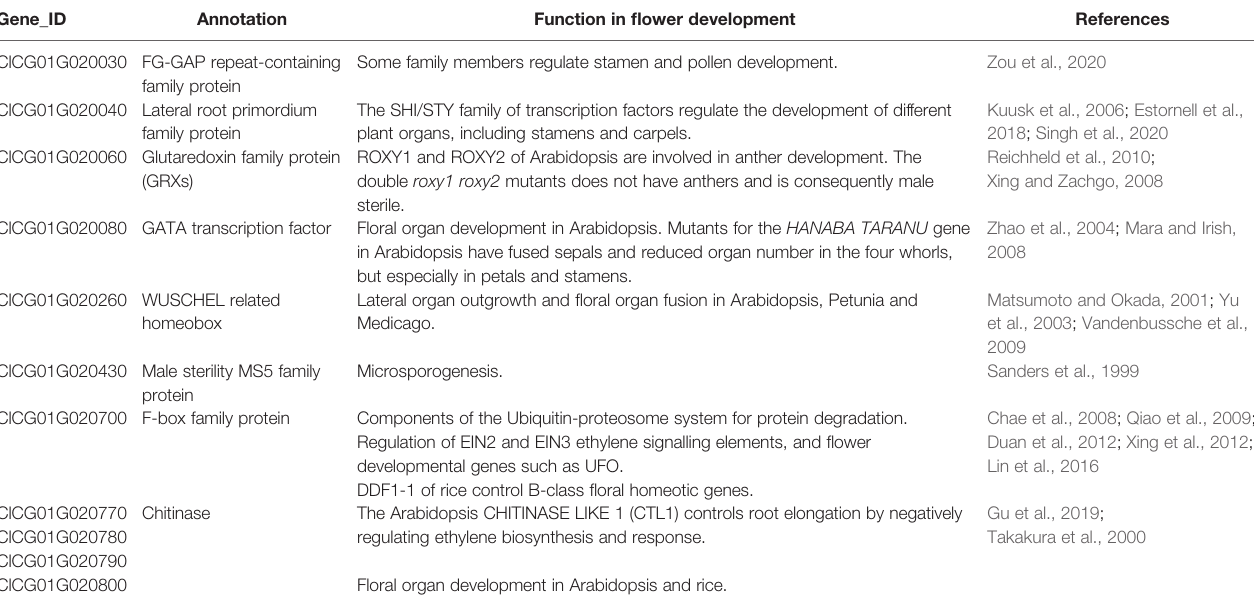
TABLE 4 | Annotated genes in the mapping region of the watermelon pa locus that are related to ethylene biosynthesis and response, or to fl ower